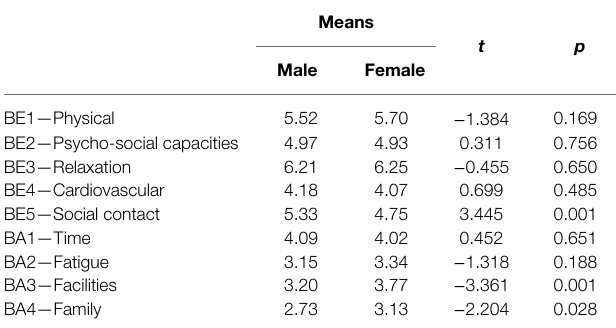
TABLE 6 | Benefit and barrier factor comparison between amateur and professional horseback riders.